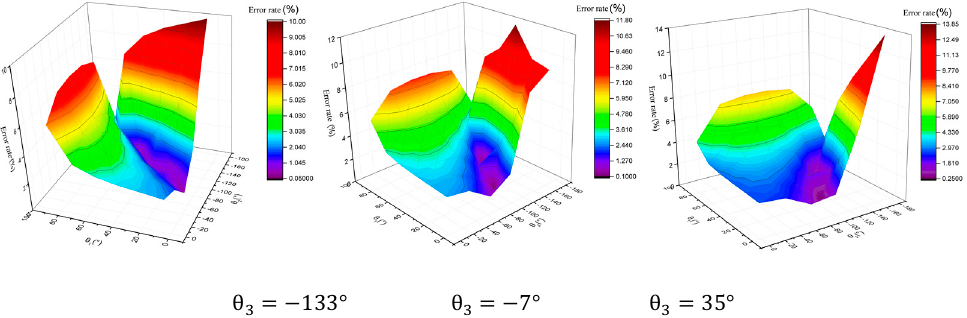
Figure 8. Relationship of compensation error of the 1st joint angle and each joint angle.